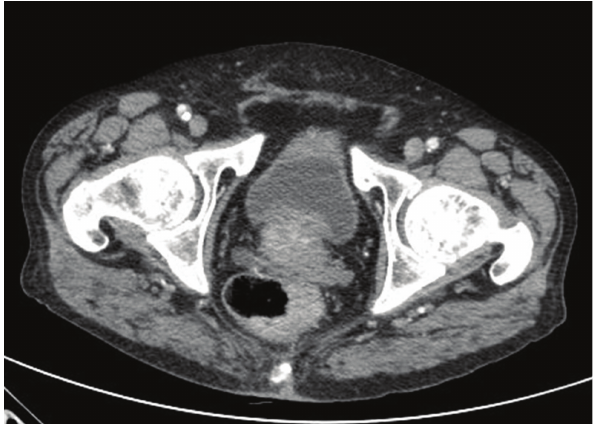
Figure 2: CT scans which show rectal mass.